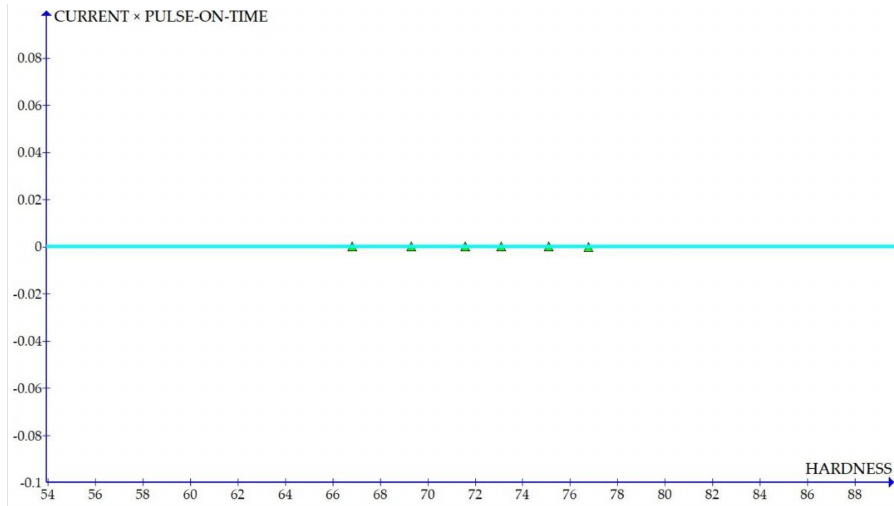
Figure 8. Coefficient of kerf width: current × pulse on time vs. hardness.